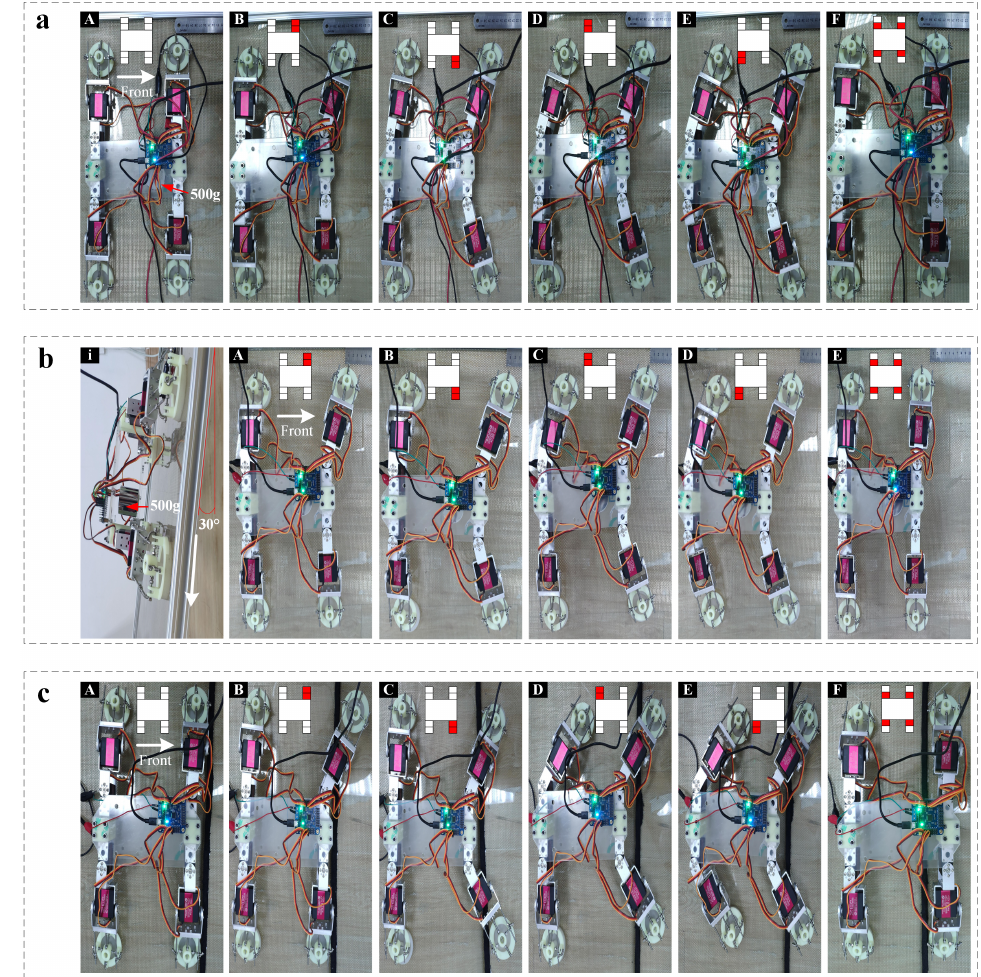
Figure 8. Demonstration of the walking and climbing mode of climbing-robot with a carried load on ground. ( a ) walking mode on a smooth acrylic surface with a carried load of a 500 g weight by actuating digital servos ( A – F ). In the top middle inset, the red color indicates digital servos activated while the white color represents the inactivation, correspondingly; ( b ) demonstration of the sequential actuating digital servos ( A – E ) for climbing on an 30° inclined acrylics surface with a carried load of 500 g; ( c ) demonstration of the sequential actuating digital servos ( A – F ) for overcoming obstacle (the height is 16 mm the width is 10